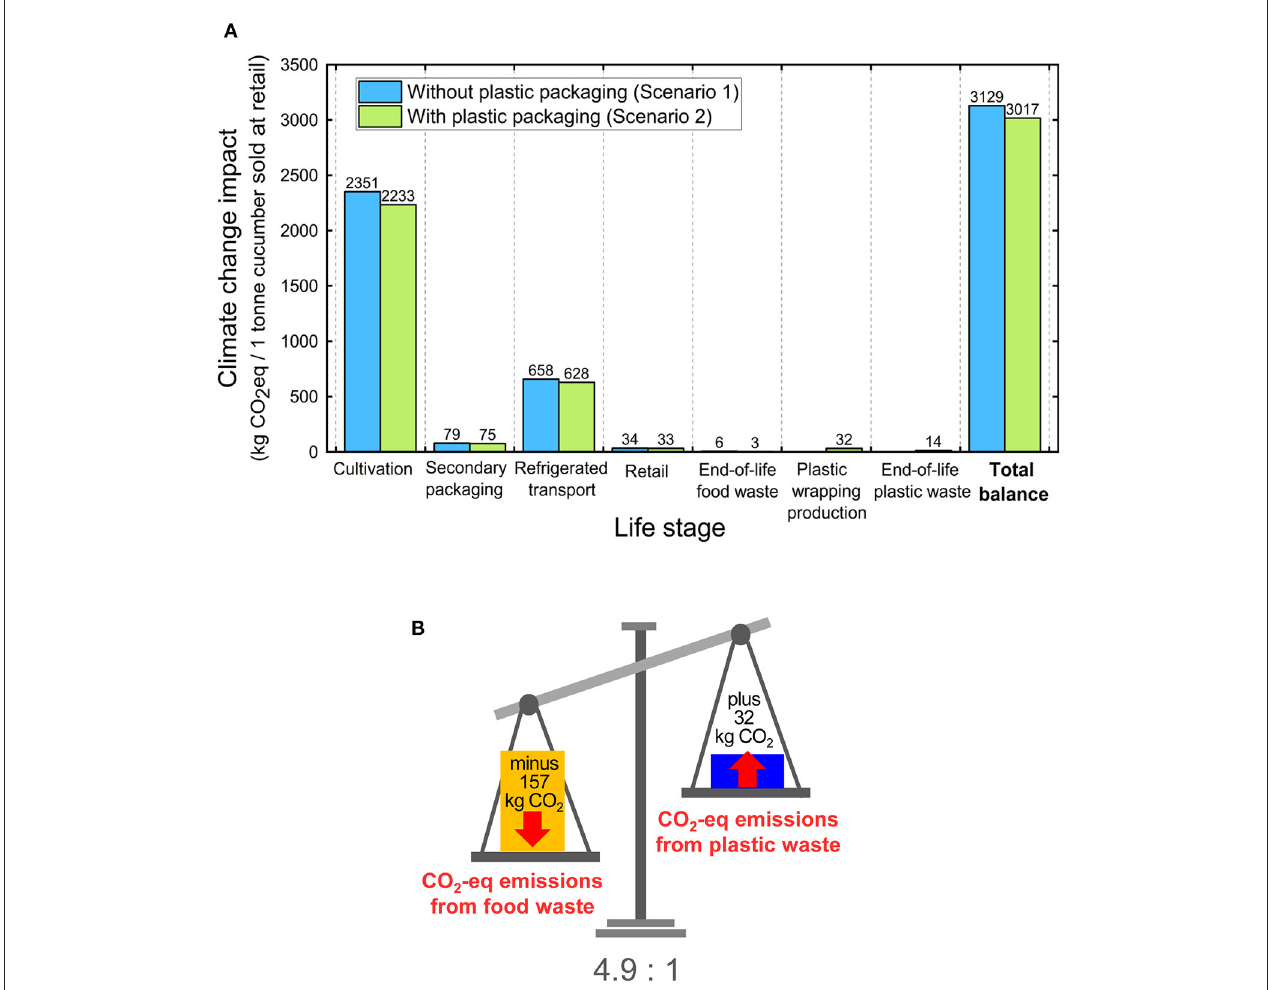
FIGURE 3 | (A) Relative differences in climate change impact throughout the cucumber lifecycle for the reference scenarios: without plastic wrapping (scenario 1) and with plastic wrapping (scenario 2). Here, we explicitly compare the difference in environmental impact arising due to food waste at the retailer, including its upstream impact and the impact due to additional plastic packaging. (B) A direct cumulative comparison between CO 2 emissions for the net balance comparing the impact of the reduction in food waste due to packaging with the impact of the packaging